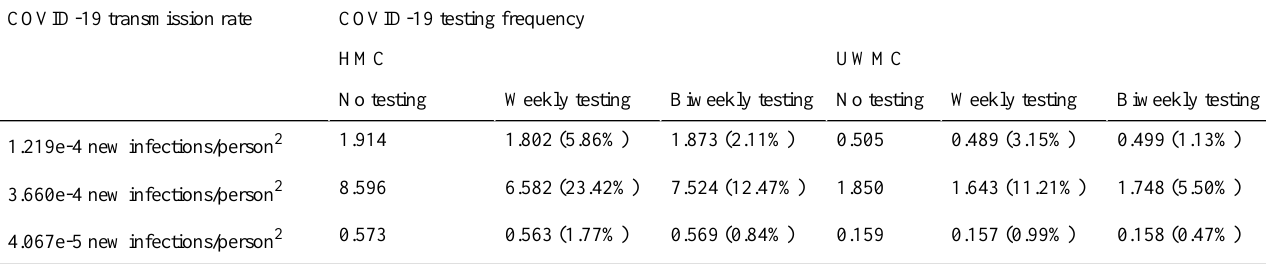
Table 2. HCW infections with and without periodic COVID-19 testing for HCW at HMC and UWMC. Predicted numbers of new HCW infections with various transmission rates and COVID-19 testing frequencies for HCW after 180 days within the emergency departments of HMC and UWMC. Percentages in parentheses represent the reduction in the number of infections at the given transmission rate with weekly (every 7 days) or biweekly (every 14 days) testing compared to the number of infections with no routine testing for HCW. HCW: health care workers; HMC: Harborview Medical Center; UWMC: University of Washington Medical Center. COVID-19 testing frequencyCOVID-19 transmission